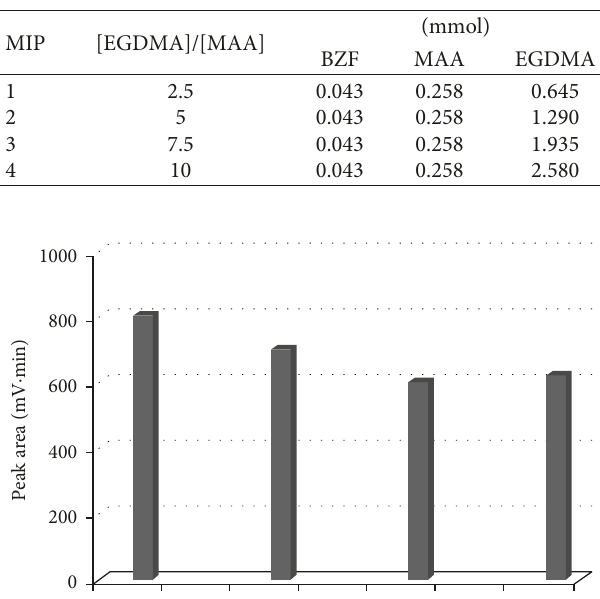
Table 2: Polymers synthesized maintaining a 6 MAA/BZF molar ratio.